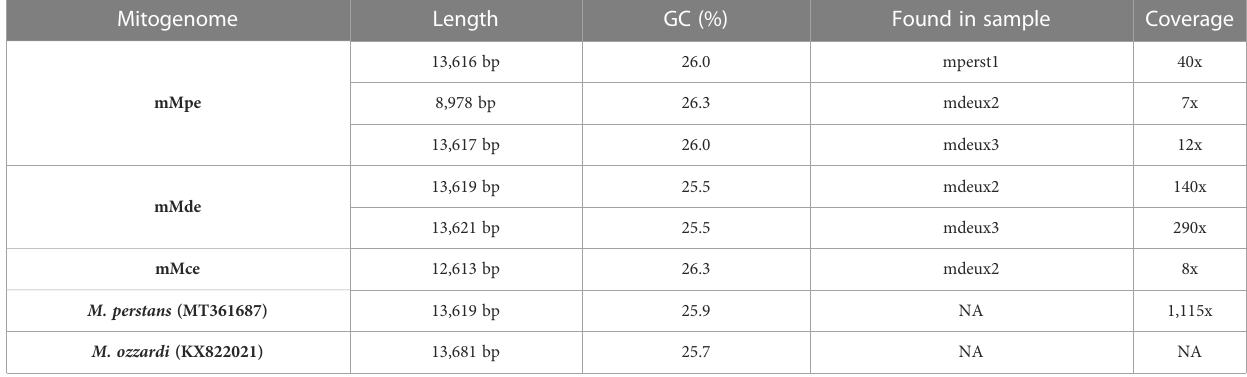
TABLE 3 Comparison of different characteristics of the generated mitogenome clusters, including the published mitogenomes from M. perstans (MT361687) and M. ozzardi (KX822021).